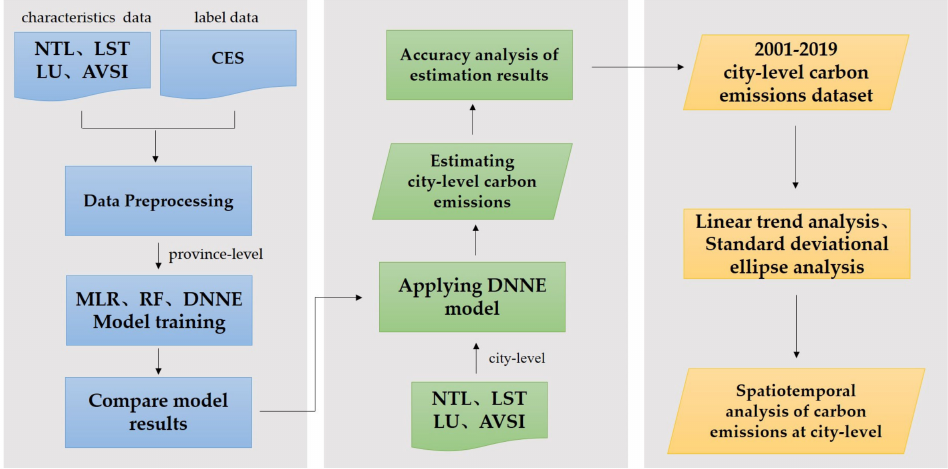
Figure 1. Flowchart of the